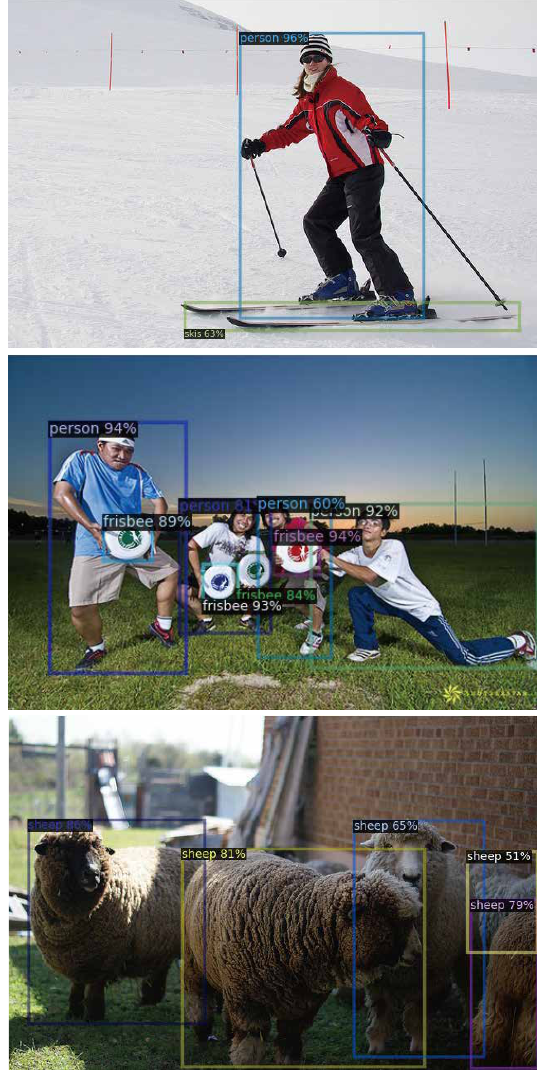
Figure 6. Qualitative detection results of our proposed end-to-end object detector on COCO val2017